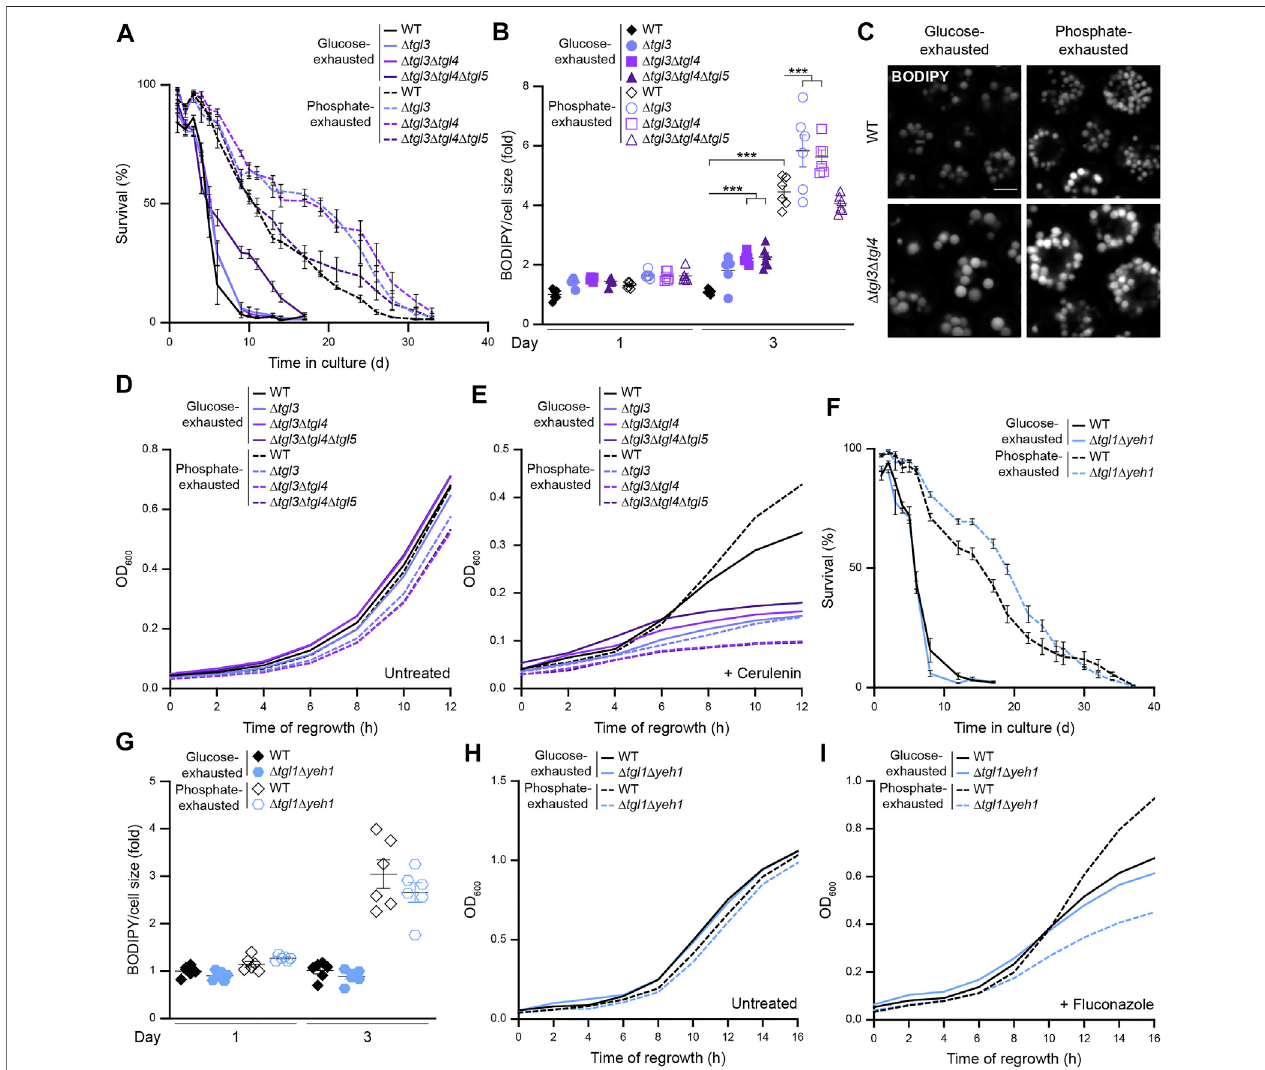
FIGURE7| Sterolesterhydrolysissupportsregrowthofphosphate-exhaustedcells (A) SurvivalofWT(BY4742), Δ tgl3 , Δ tgl3 Δ tgl4 and Δ tgl3 Δ tgl4 Δ tgl5 cellsduring chronological aging, determined via fl ow cytometric quanti fi cation of propidium iodide staining at indicated time points after glucose or phosphate exhaustion. Mean ± SEM;n=6 (B) Flowcytometricquanti fi cationofneutrallipidcontentviaBODIPYincellsdescribedin(A).BODIPYmean fl uorescenceintensitywasnormalizedtocellsize and dataisshown asfoldofglucose-exhaustedWTcellsatday 1.Mean±SEM;n=6 (C) ConfocalmicrographsofBODIPY-stainedWTand Δ tgl3 Δ tgl4 cellsupon glucoseorphosphateexhaustionatday3.Scalebar:2 μ m (D,E) Regrowthofcellsdescribedin(A)after3daysofglucoseorphosphateexhaustion.Nutrient-exhausted cells were re-inoculated in unrestricted, fresh standard medium and OD 600 was monitored every 2 h. Cells were left untreated (D) or were treated with 1 µM cerulenin at the time point of re-inoculation (E); n = 6 (F) Survival of WT and Δ tgl1 Δ yeh1 cells during chronological aging, determined via fl ow cytometric quanti fi cation of propidium iodidestainingatindicatedtimepointsafterglucoseorphosphateexhaustion.Mean±SEM;n=6 (G) Flowcytometricquanti fi